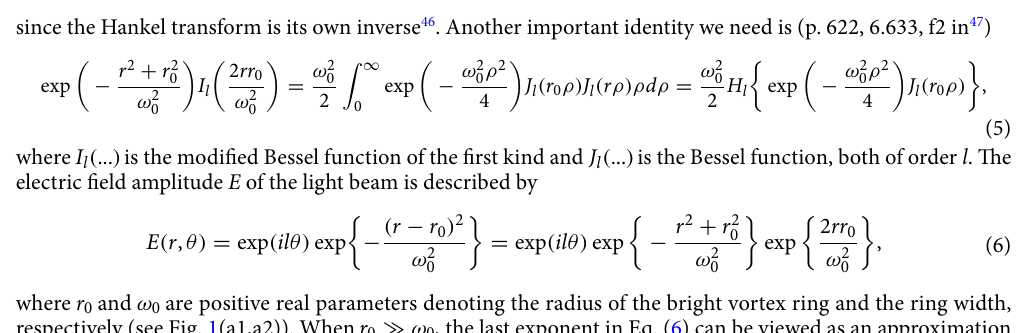
Figure 1. Distribution of the input electric field amplitude E of the light beam described by Eq. (6) for r 0 /ω 0 = 10 (panel ( a1 )) and 20 (panel ( a2 )), where ω 0 =const. Panel ( b )—typical phase profile of the central peak of the first-order GBB. Radial distributions according to Eq. (10) of the far field electric field amplitudes E ′ of zeroth- ( c ) and first-order GBBs ( d ) for r 0 /ω 0 =10 (black dashed curves) and 20 (red solid